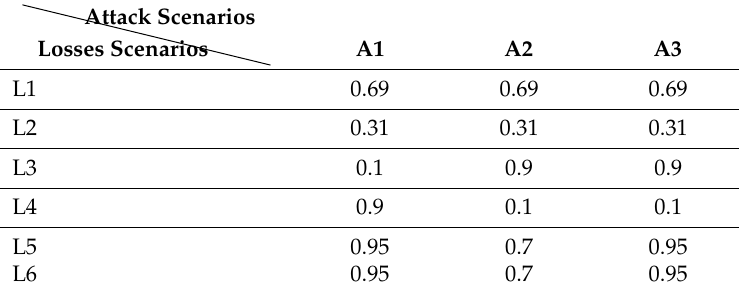
Table 5. Conditional probabilities of loss scenarios for every attack